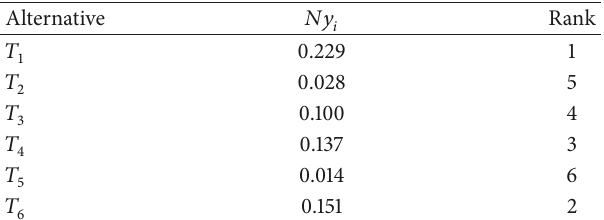
Table 16: Comparison of rank for each alternative. Alternatives IF-MOORA PF-TOPSIS 𝑃 0.434 1